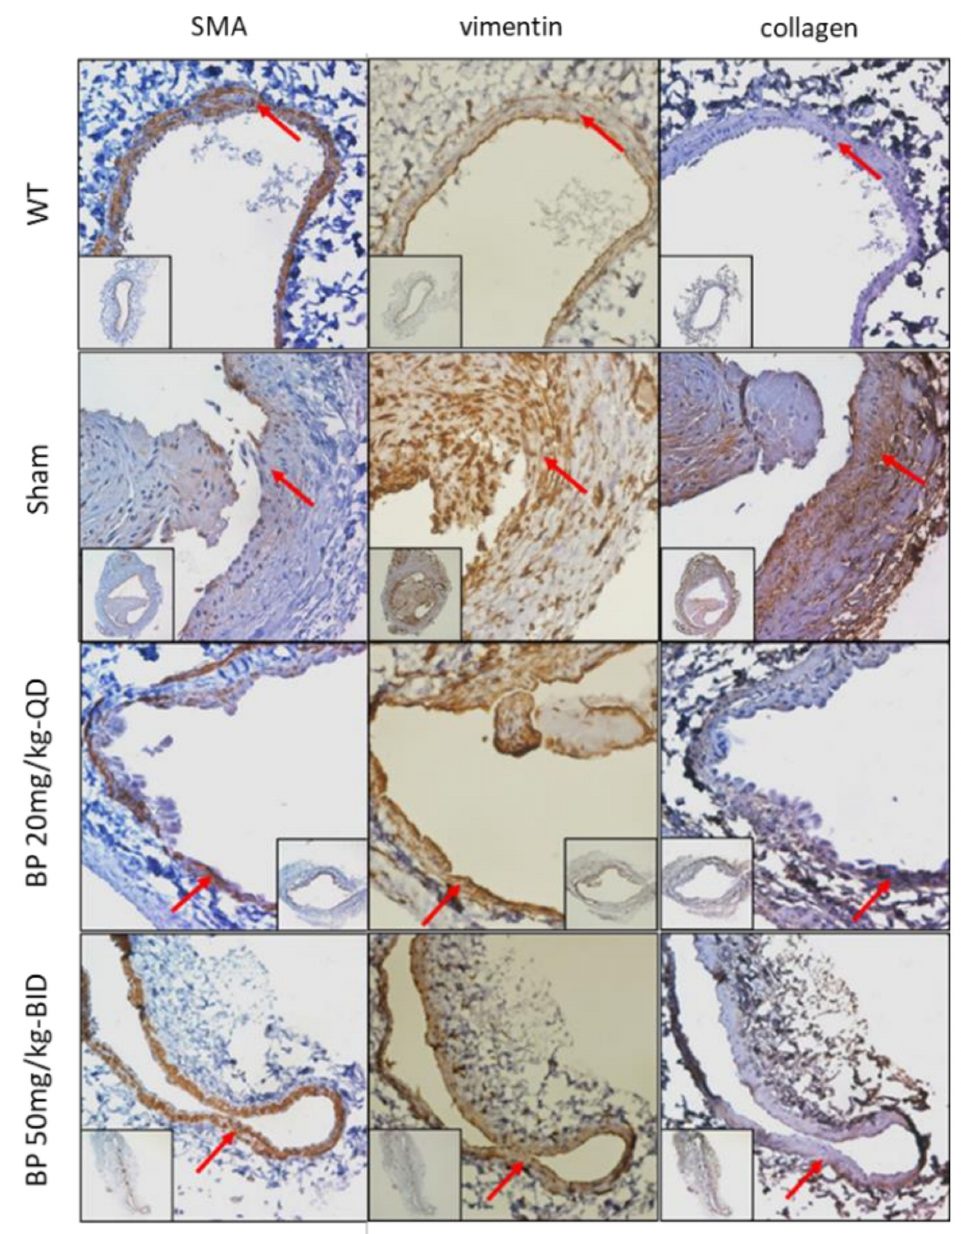
Figure 4. Immunohistochemical detection (brown color) of a venous limb of AVF from rats treated with di ff erent doses of BP for 30 days. The expression of a phenotypic-specific marker (SMA, vimentin and collagen I) in an adjacent section of each group is indicated by a red arrow. Significant inhibition of phenotypic switch was observed in rats treated with BP compared to the control (sham) group. Scale bar = 100 µ